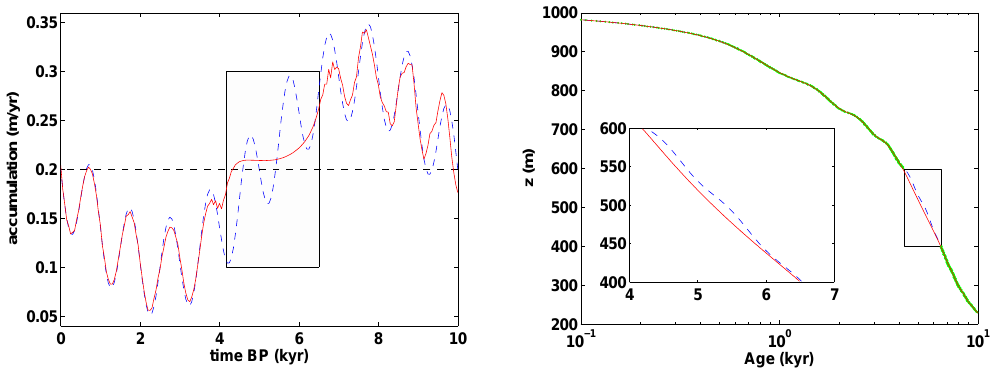
Figure 3. Recovered accumulation (red, left panel) and age–depth distribution (red, right panel) from age–depth synthetic data (green, right panel). The synthetic age–depth distribution has been obtained by adding 1% uniform noise to the reference solution (blue, right panel) derived from the reference accumulation record (blue, left panel) and considering a gap in the data (400m < z < 600m). The inset in the right panel shows a close-up of the age–depth results where there is a gap in the age–depth data.